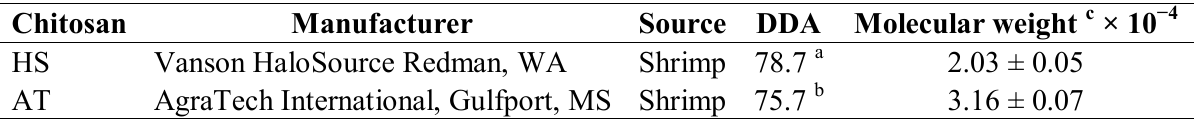
Table 1. Chitosan properties.